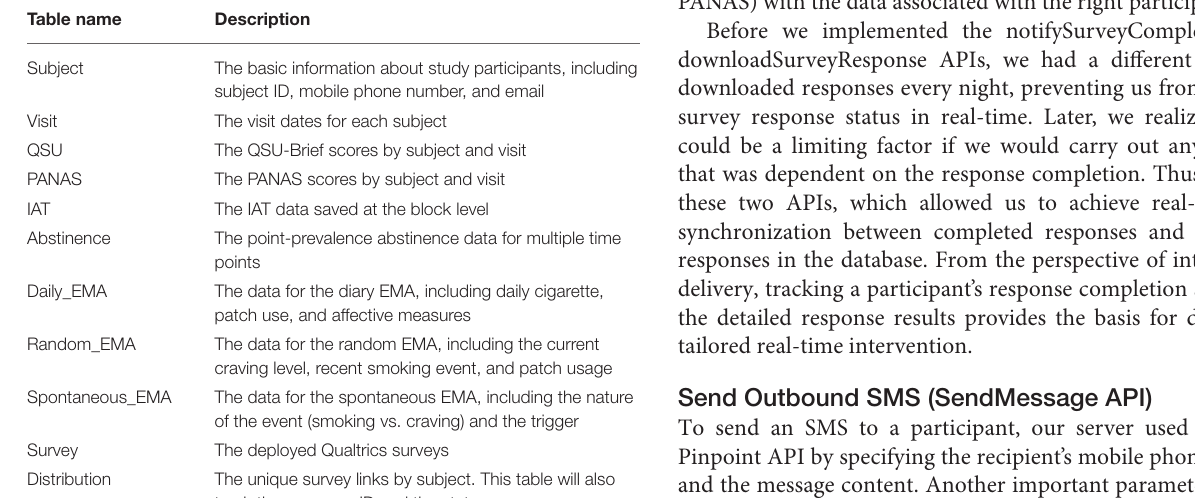
TABLE 3 | Data tables in the SQL